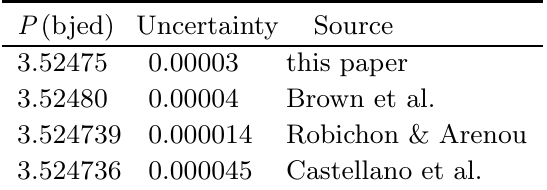
Table 2. Various period determinations for the HD 209458